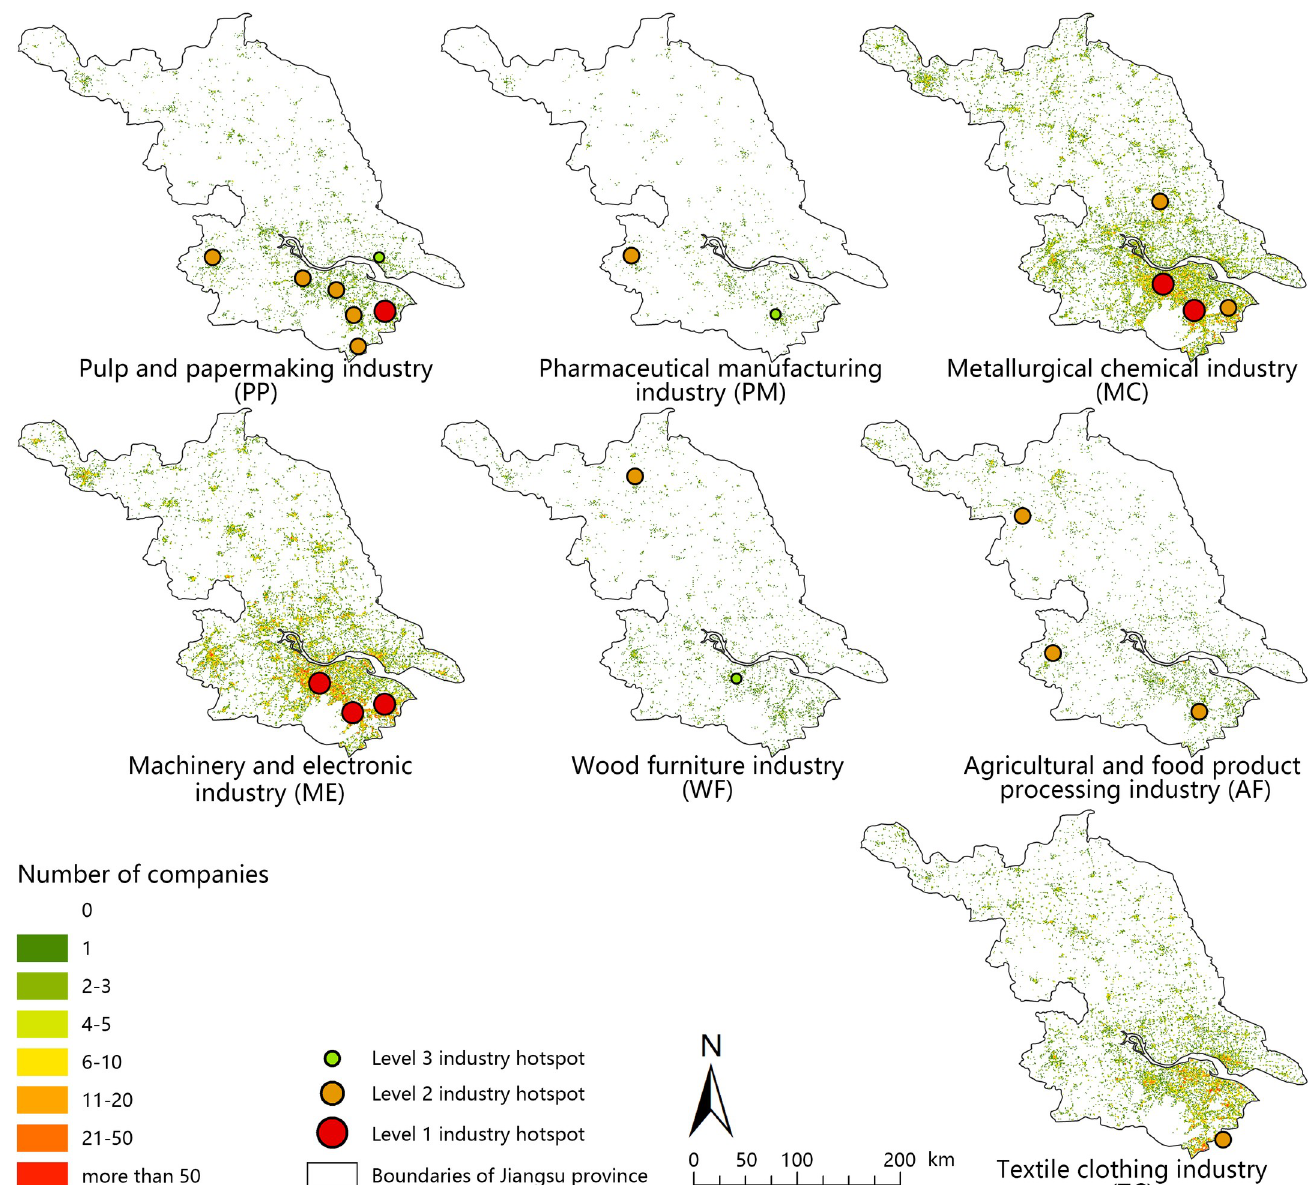
Fig 3. Distribution pattern of various manufacturing industries in Jiangsu province in 2020. Number of different industries in a 1 km × 1 km projection grid in 2020. Hotspots in 2020 were calculated based on manufacturing POIs distribution. The maps were generated by ArcGIS 10.5 and were for illustrative purposes